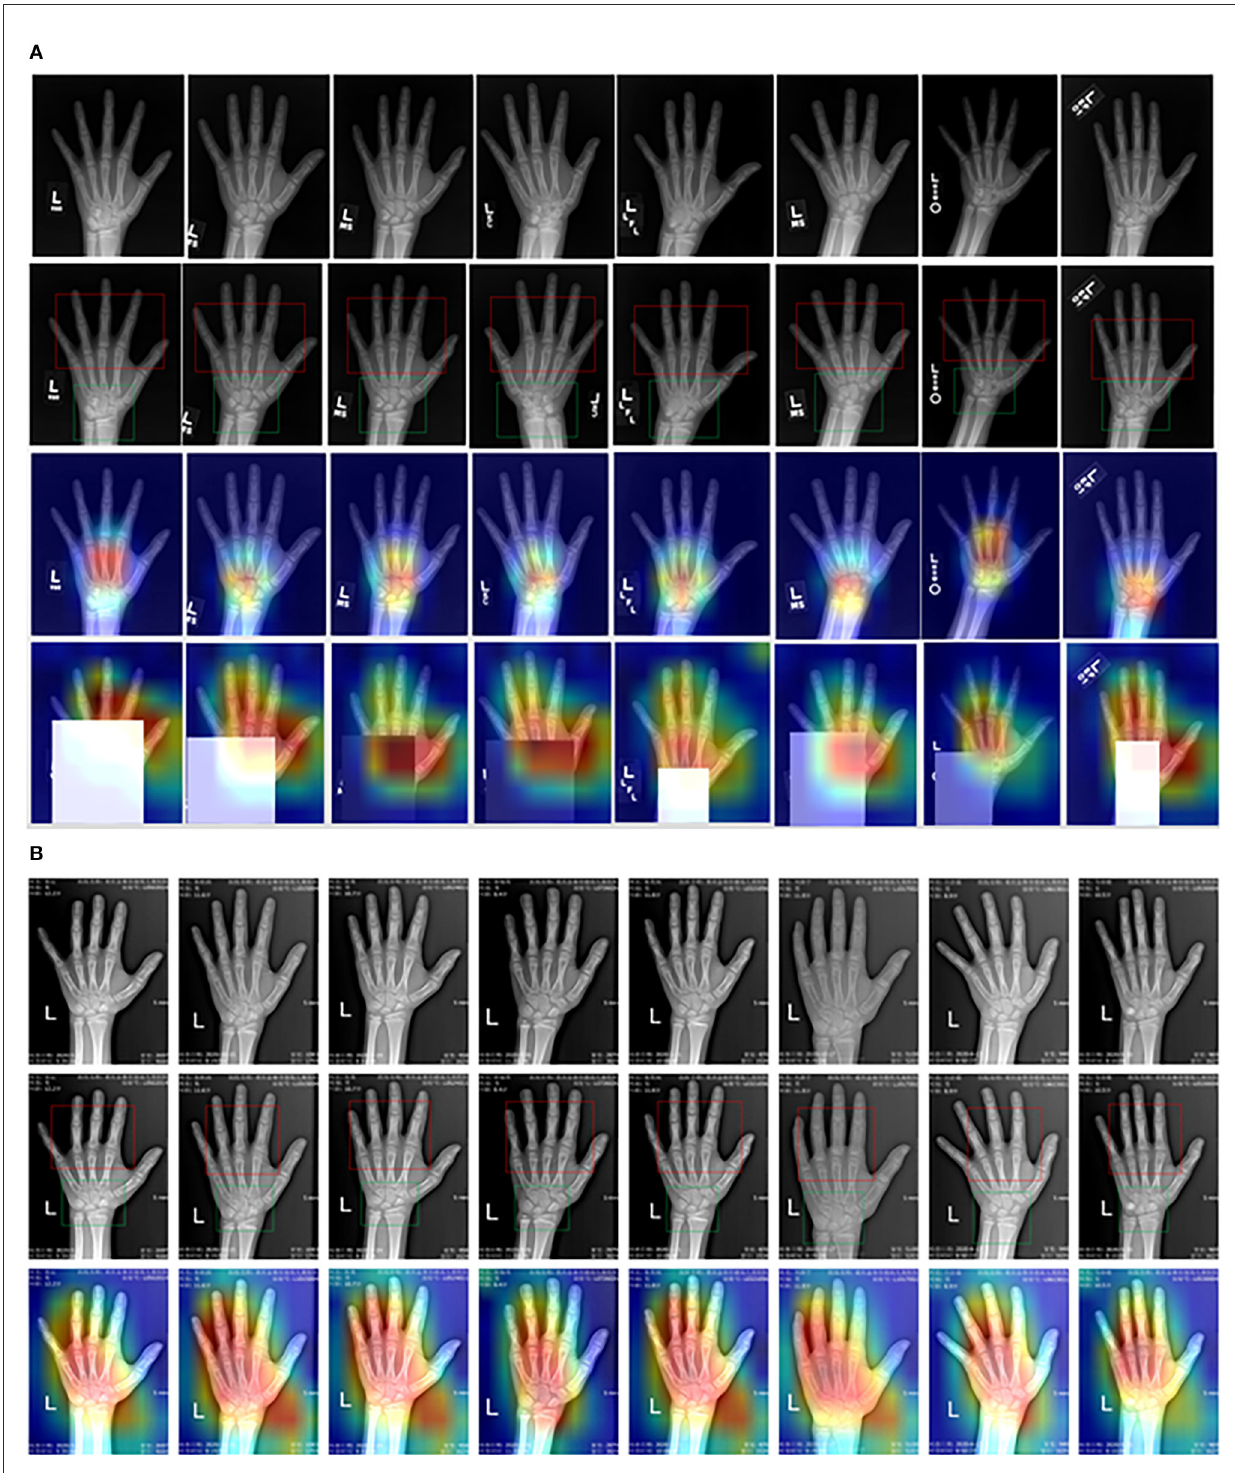
FIGURE9 Visual heat map of critical bone region (A) RSNA dataset, (B) CQJTJ dataset.